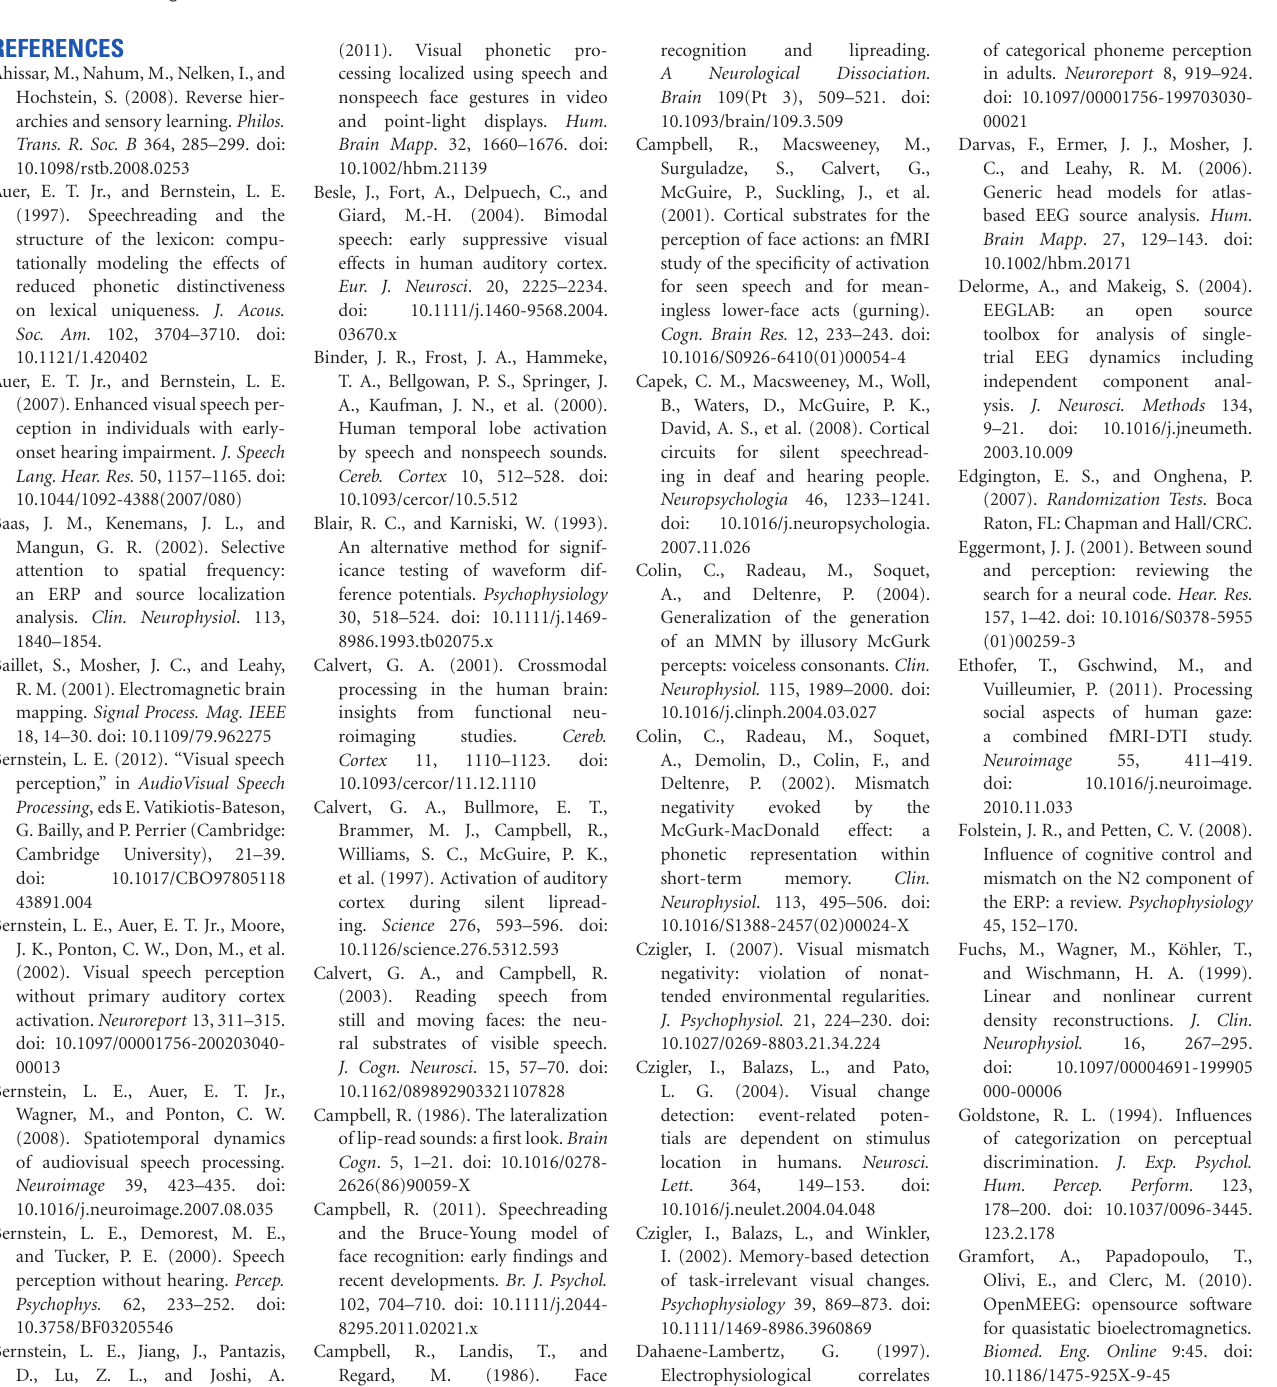
0 to 500ms post-deviation onset. Images are thresholded at 20pA · m. Focal activity in right posterior temporal cortex begins at 240ms and continues through the end of the temporal interval, spreading to posterior inferior temporal and lateral occipital cortex at ∼ 340ms. Right fronto-lateral activity begins at 260ms and continues through the end of the interval. Left fronto-central activity begins at 220ms and continues through the end of the interval. Left posterior temporal activity occurs from 200 to 380ms and in a slightly more inferior region from 460ms to the end of the temporal